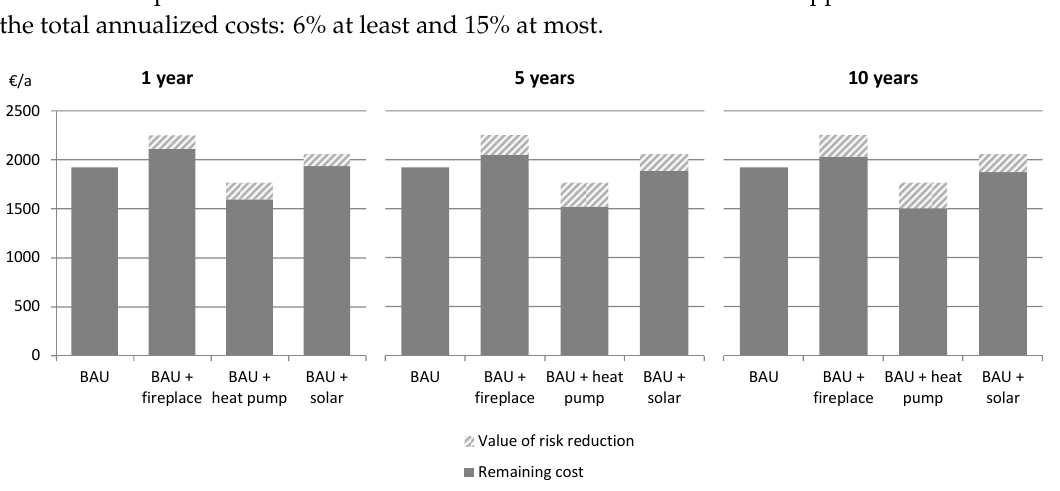
Figure 3. The value of price risk reduction and remaining cost in each case for three different timespans used in the calculation.